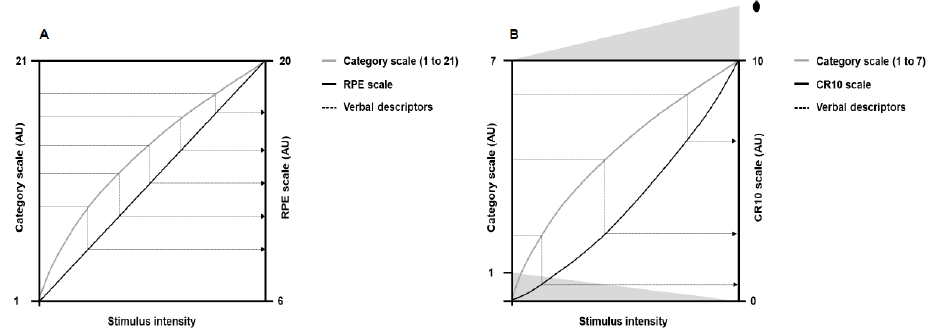
Figure 2. Illustration of the theoretical principle behind the verbal descriptors shifts (dotted lines) from the 21-points and 7-point category scales to the rating of perceived exertion (RPE) and category-ratio 10 (CR10) scales, respectively. Panel ( A ) shows perceived exertion responses to the 21-point scale (gray line) and the RPE scale (black line) as a function of the physical stimulus intensity. Panel ( B ) shows perceived exertion responses to the 7-point category scale (gray line) and the CR10 scale (black line) as a function of the physical stimulus intensity. The dot above number 10 represents a number people can choose to quantify maximal exertion. Adapted from Borg [4] .